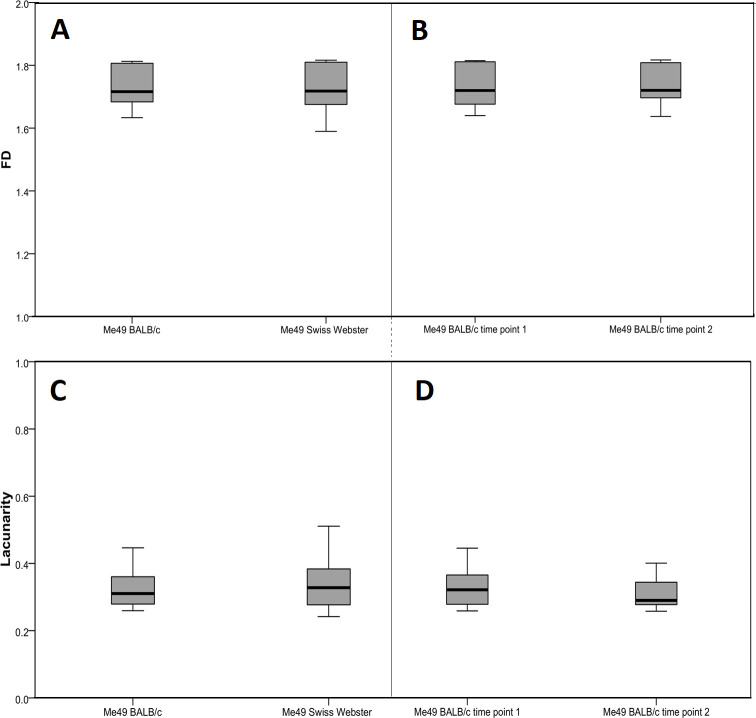
Fractal dimension (FD) and lacunarity of cysts (n = 31) of the Me49 T. gondii strain according to host and cyst age.The number of analyzed cyst images is as follows: Me49 BALB/c time point 1 (n = 3), Me49 BALB/c time point 2 (n = 3), Me49 SW (n = 7). Twelve randomly positioned sets of measurement grids per image were used. (A) FD and (C) lacunarity in BALB/c and Swiss Webster mice. (B) FD and (D) lacunarity at two time points (6 and 12 weeks) in the BALB/c host. No statistically significant differences were found between any two examined groups (host: UFD = 2823.5, Ulacunarity = 2818; cyst age: UFD = 573, Ulacunarity = 525; p > 0.05).